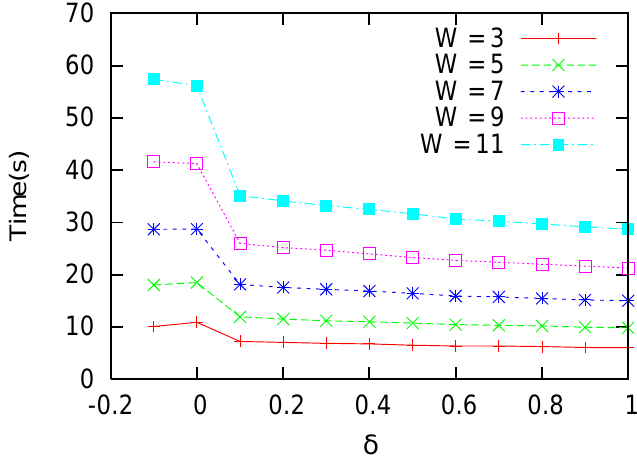
Figure 17. Time needed for computing the disparity by our approach in the Corridor